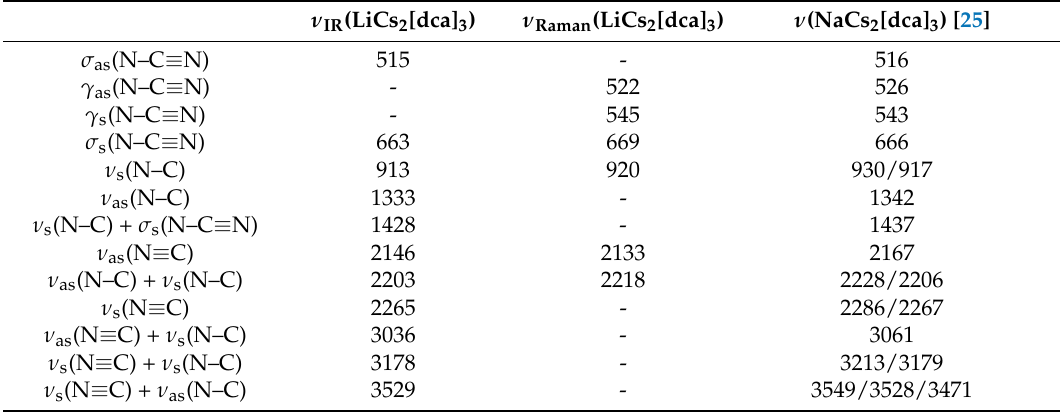
Table 2. IR and Raman data of LiCs 2 [dca] 3 in comparison to NaCs 2 [dca] 3 . All numbers are given in cm − 1 .